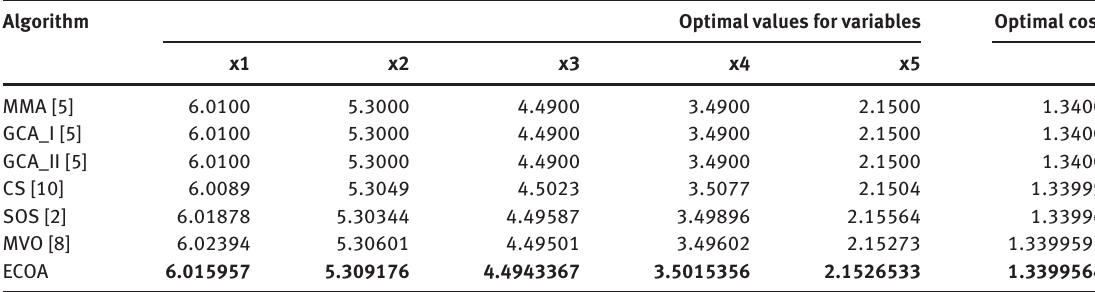
Table 7: Comparison Results for the Cantilever Beam Design Problem.